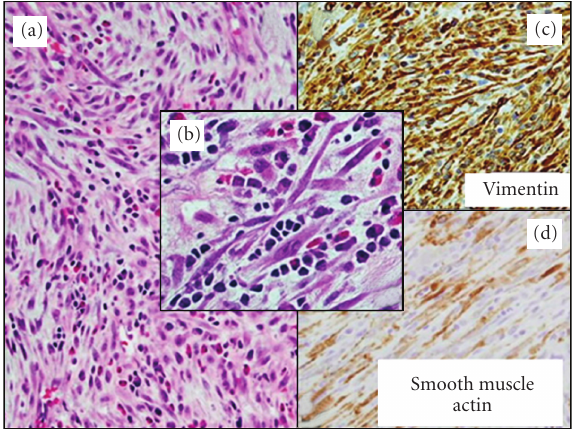
Figure 4: (a) and (b) Histopathology of tumor showing pro- liferation of myofibroblasts, inflammatory cells, spindle, and fusiform cells in a myxoid stroma (hematoxylin & eosin, x100 & x400 magnifications). (c) Immunophenotype—Vimentin expression in myofibroblastic population (immunoperoxidase, x200). (d) Immunophenotype—Smooth muscle actin coexpression (immunoperoxidase,